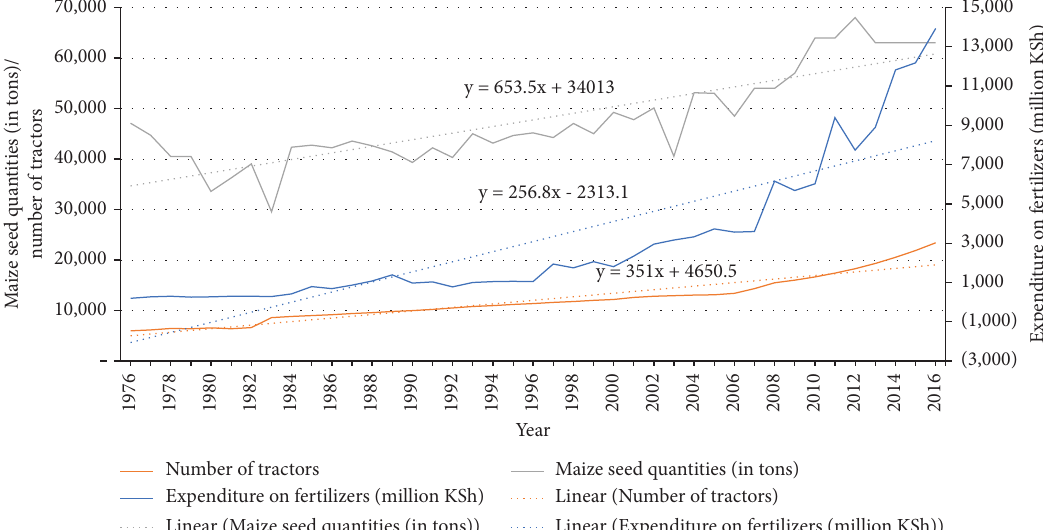
Figure 2: Te trend of the number of tractors, expenditure on fertilizers, and maize seed quantities